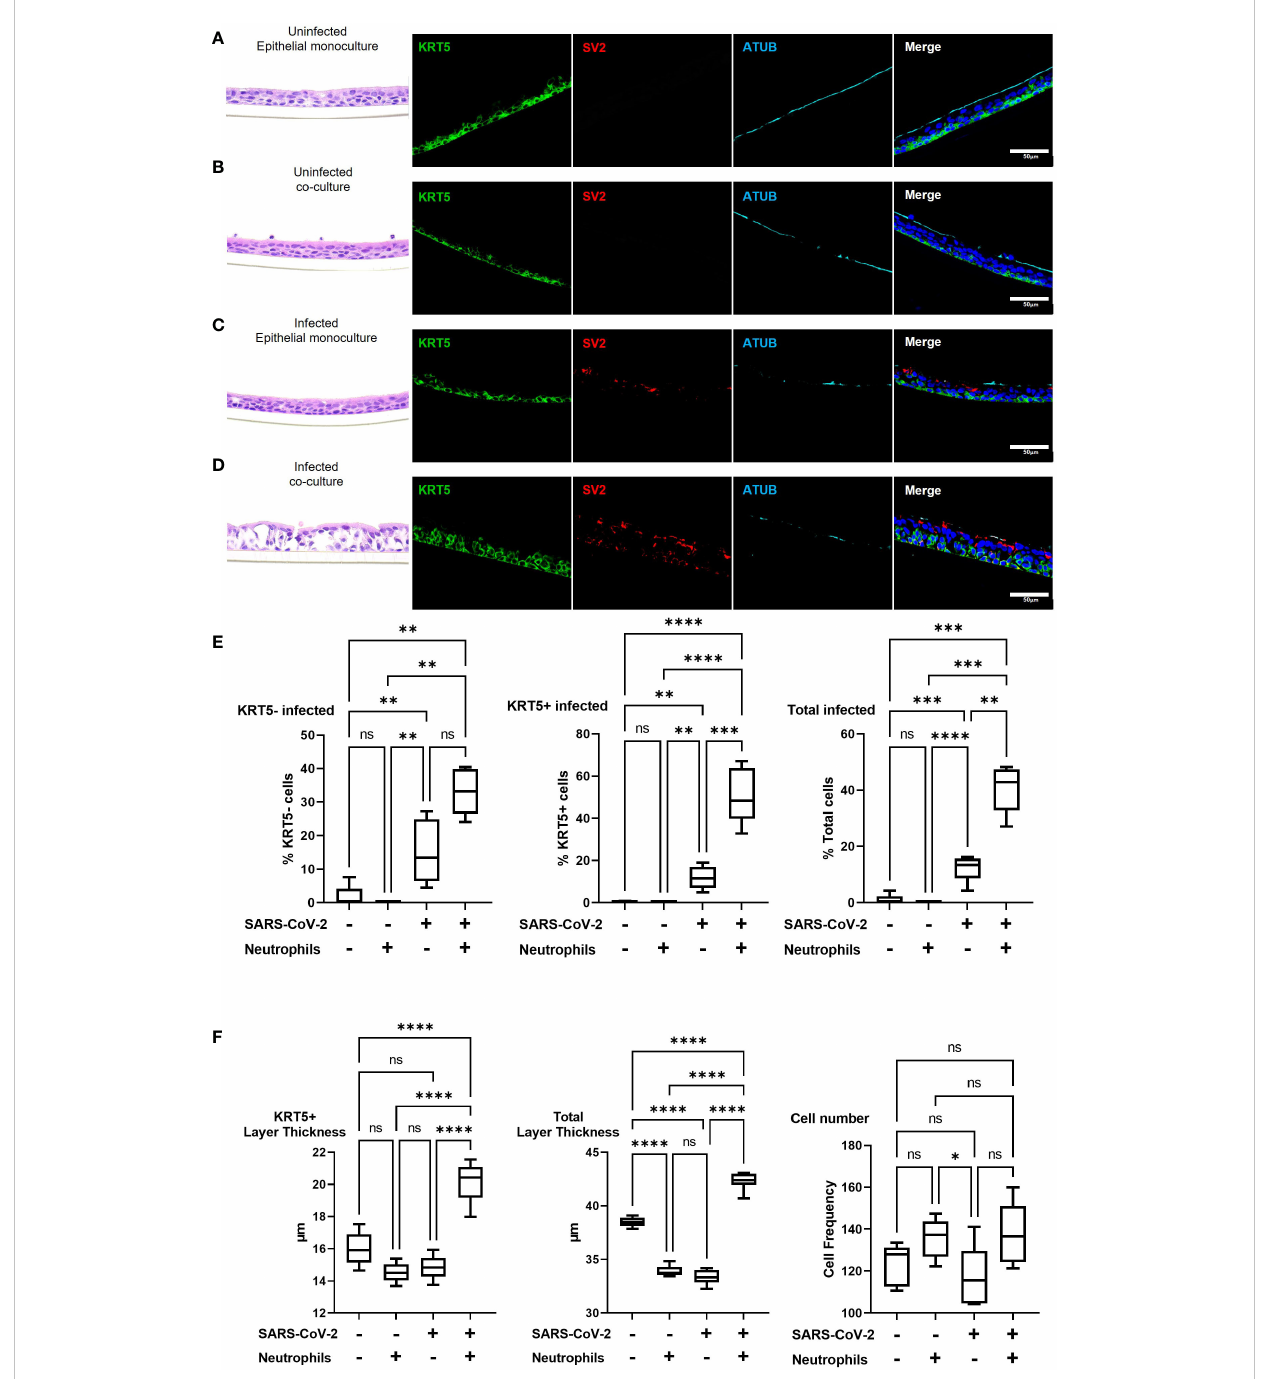
FIGURE 3 Pre-existing neutrophils allow for SARS-CoV-2 infection of KRT5+ Basal cells. a-d representative hematoxylin and eosin (H&E) staining and immuno fl uorescent images of cross section culture models probed for KRT5 (green) SARS-CoV-2 (red) and alpha-tubulin (cyan). (A) uninfected monocultured epithelial cells. (B) uninfected epithelial:neutrophil co-cultures. (C) SARS-CoV-2 infected epithelial cell monoculture. (D) SARS-CoV-2 infected epithelial:neutrophil co-cultures. All IF images have nuclei counterstained with DAPI (blue) and scale bars represent 50 m m. (E) Image analysis quanti fi cation of infected KRT5-, KRT5+ and total cells. (F) Image analysis of cell layer thickness for KRT5+ Cells and Total cells All images are representative of 3 independent experimental repeats of 3 neutrophil and 3 epithelial random donor pairings. Data is expressed as Tukey method box & whiskers plots. Signi fi cance is determined by analysis of variance (ANOVA) followed by Tukey ’ s post hoc analysis. *p<0.05,**p<0.01, ***p<0.001, **** p<0.0001 from n=3 experimental repeats from N=3 donors. ns, not signi fi